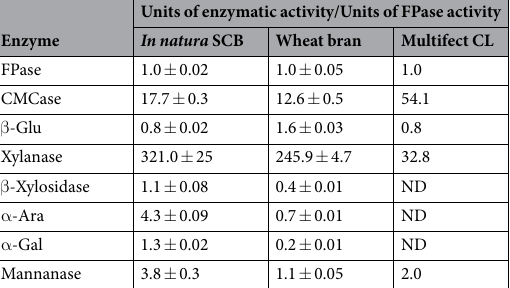
Table 5. Comparative analysis of cellulase and hemicellulase activities of the extracts produced by Chrysoporthe cubensis under SSF with in natura sugarcane bagasse (SCB) or wheat bran in comparison to Multifect CL 3 . The values displayed were obtained dividing each total enzymatic activity by total FPase activity found in each cellulolytic extract.